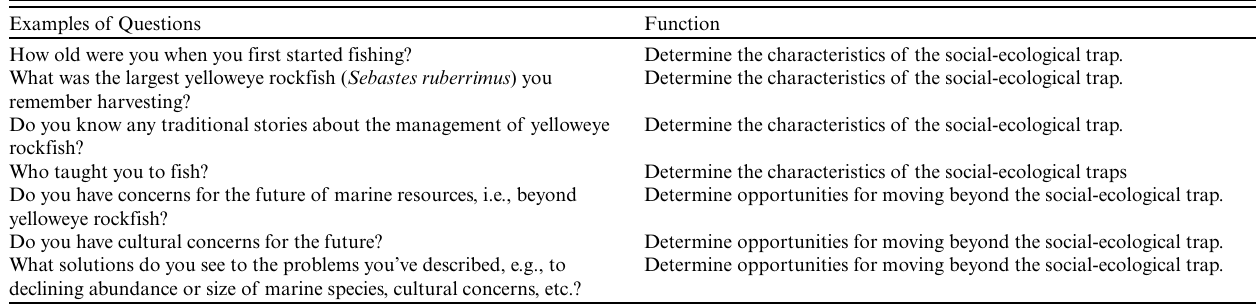
Table 1 . Examples of questions raised in the semistructured interview questionnaire and corresponding social-ecological trap themes